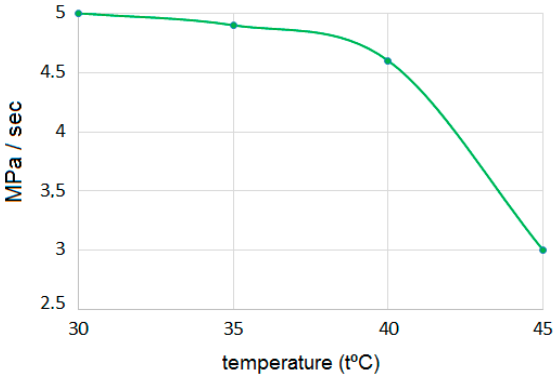
Figure 8. The rate of detachment of the oxide-zirconium coating with deposition temperature.